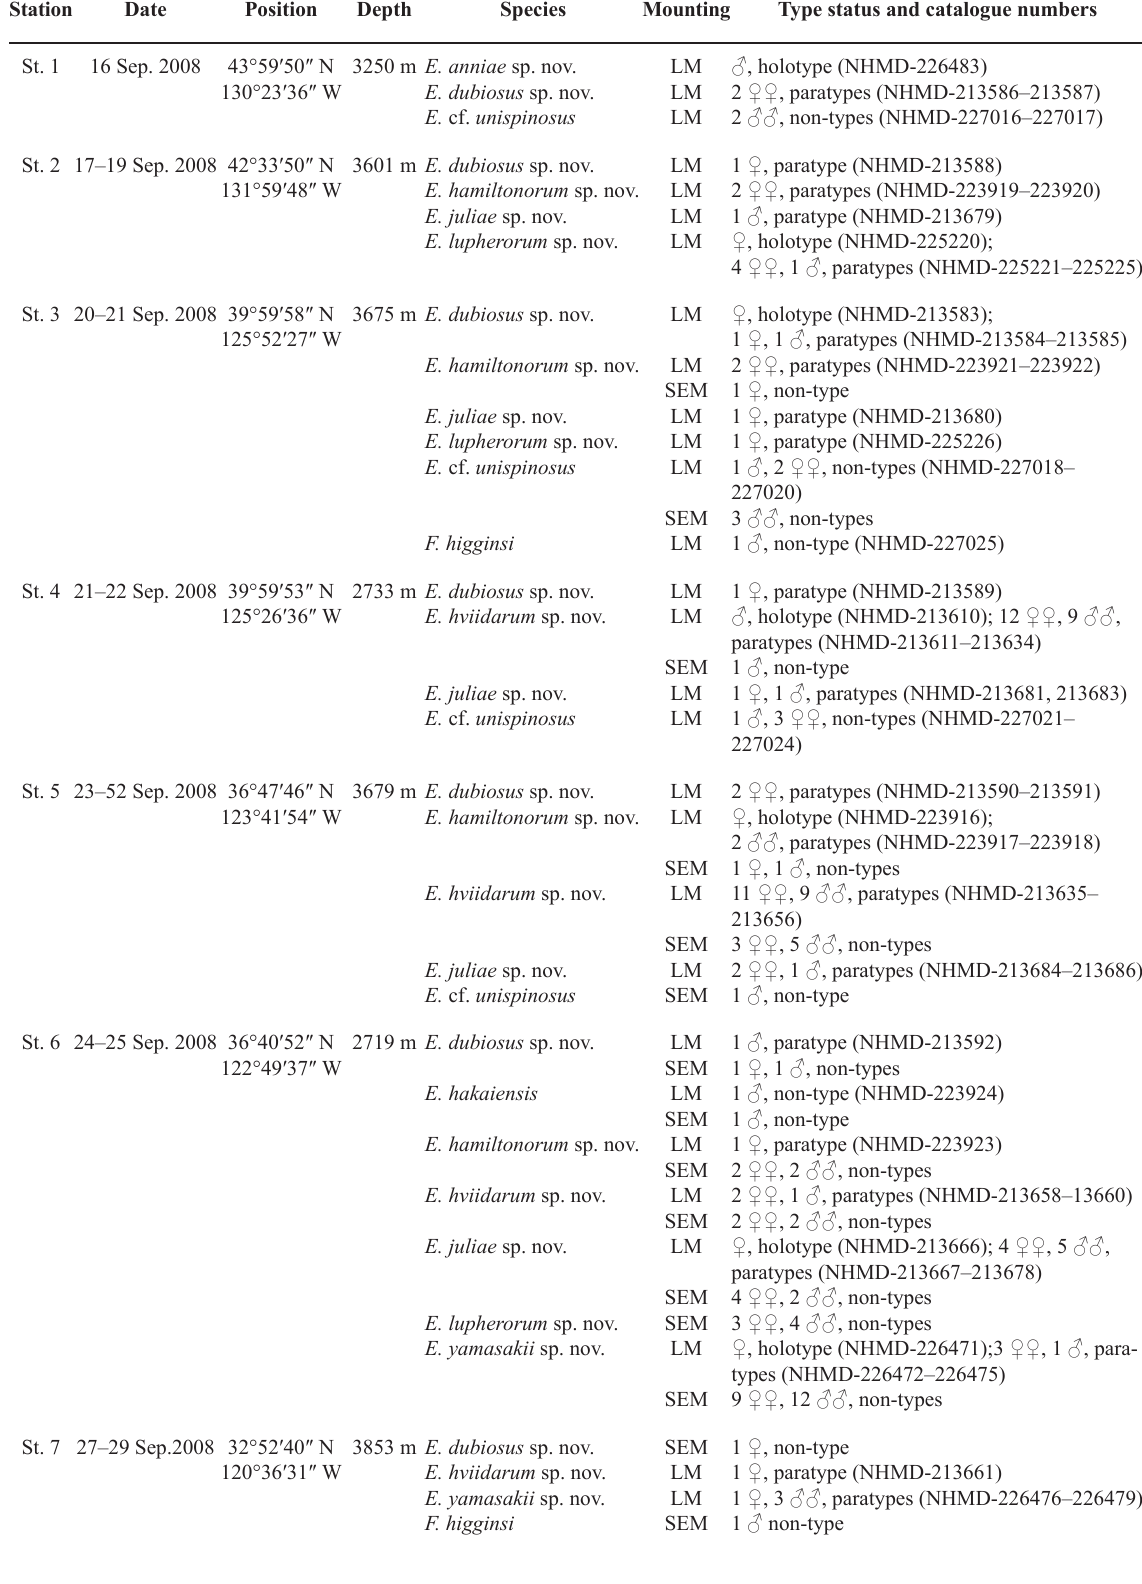
Table 1 (continued on next page). Summary of data on stations, species identities, and catalogue